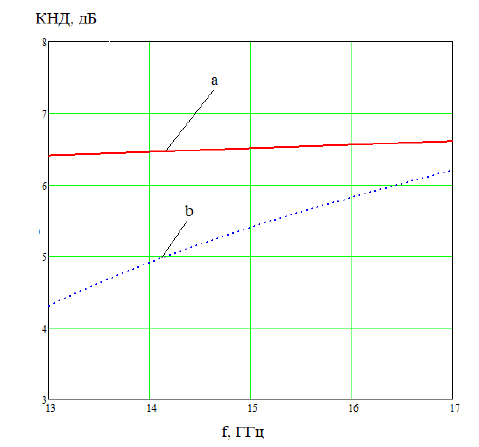
Fig. 4. Dependencies of the directivity factor on the frequency of printed emitters without spikes (a) and with spikes